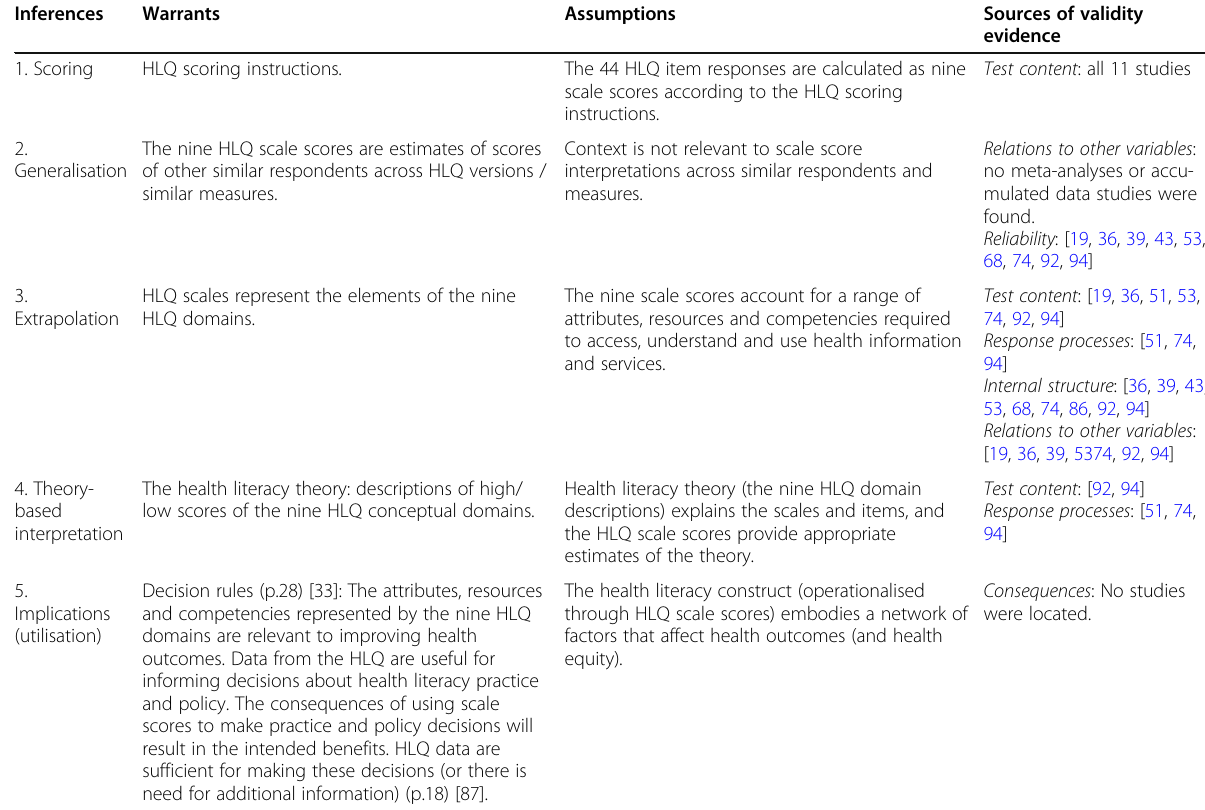
Table 5 The inferences, warrants and assumptions of the general HLQ interpretive argument, and existing sources of validity